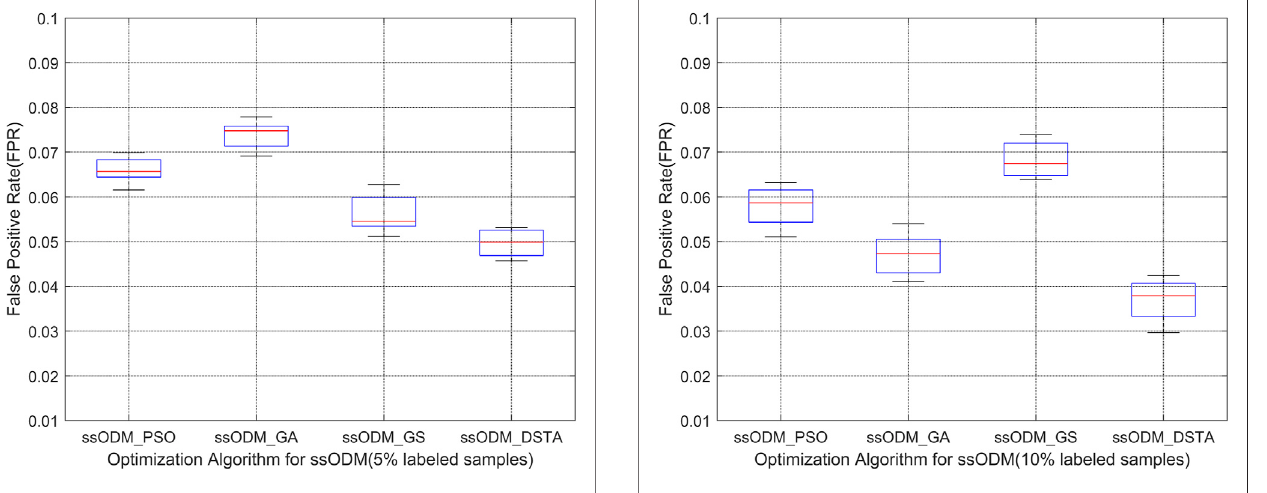
FIGURE 7 | Boxplot of FPR of CAN communication fault detection regarding blade 1 servo driver (5% labeled samples).